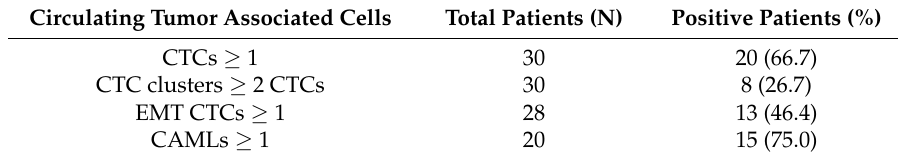
Table 1. Summary of CTCs, CTC-clusters, EMT CTCs, and CAMLs detected in MBC patients. Circulating Tumor Associated